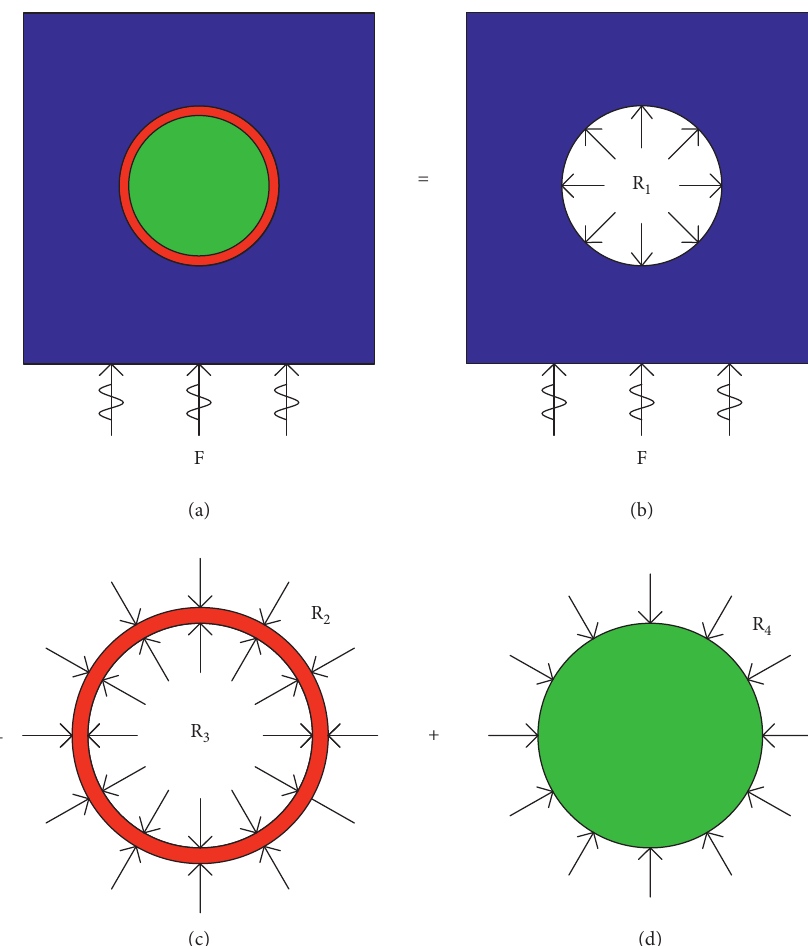
Figure 1: Mechanical models of multimaterial in hydraulic tunnel. (a) Hydraulic tunnel. (b) Rock. (c) Lining. (d)